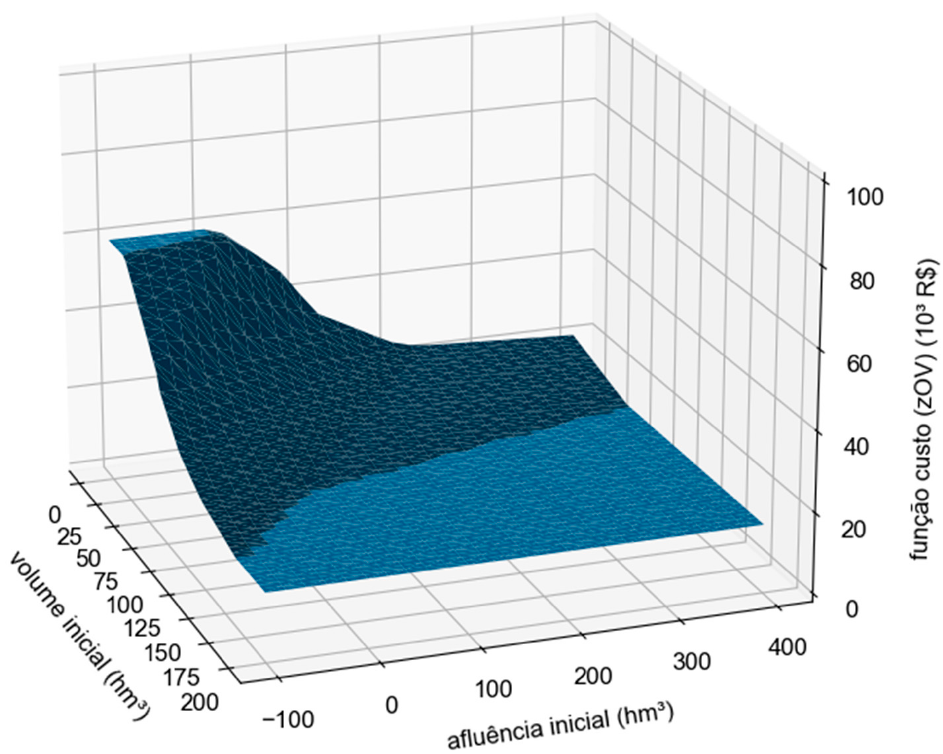
Figure 3. Cost function ( 𝑧 (cid:3016)(cid:3023) ) (10 3 $) per initial volume (hm 3 ) and initial inflow (hm 3 ).